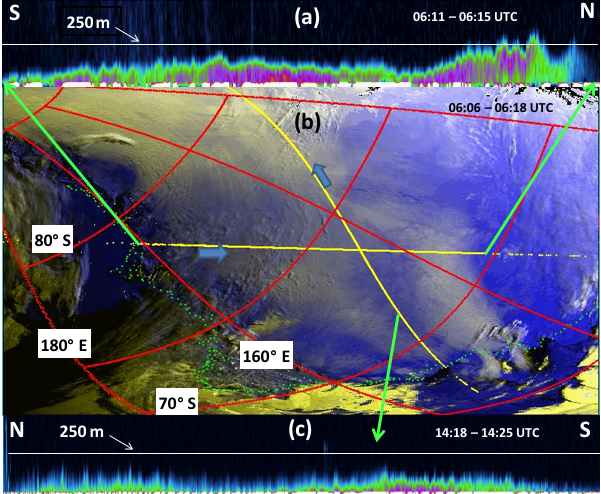
Figure 6. A large blowing snow storm over Antarctica with blow- ing snow transport from continent to ocean on 14 October 2009. (a) CALIOP 532nm attenuated backscatter along the yellow (south to north) line bounded by the green arrows as shown in panel (b) at 06:11–06:15UTC. (b) MODIS false-color image at 06:06:14– 06:17:31UTC showing blowing snow as dirty white areas. The coastline is indicated by the green dots, and two CALIPSO tracks, where blowing snow was detected are indicated by the yellow lines. (c) CALIOP 532 nm attenuated backscatter along the yellow (north to south) line, 14:18–14:25UTC.